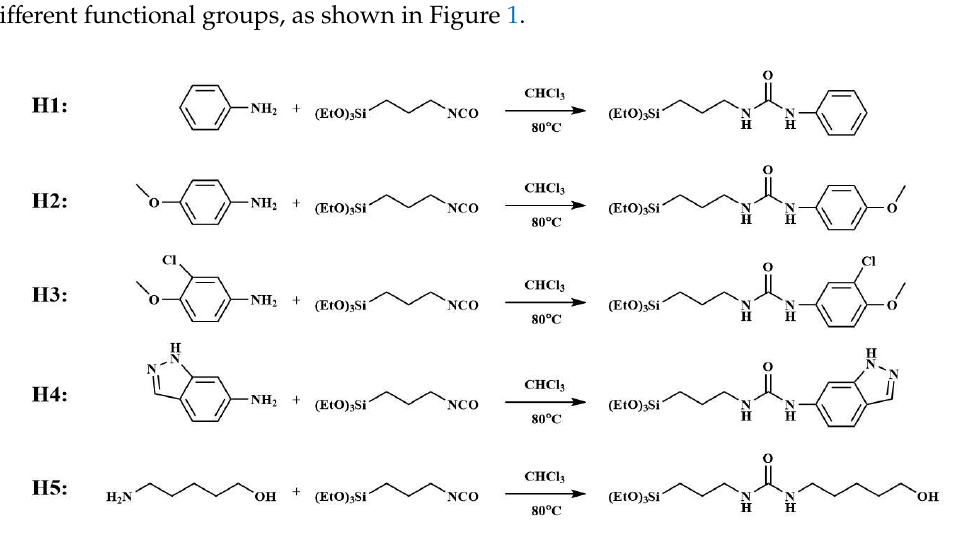
Figure 1. Synthesis of H1–H5.